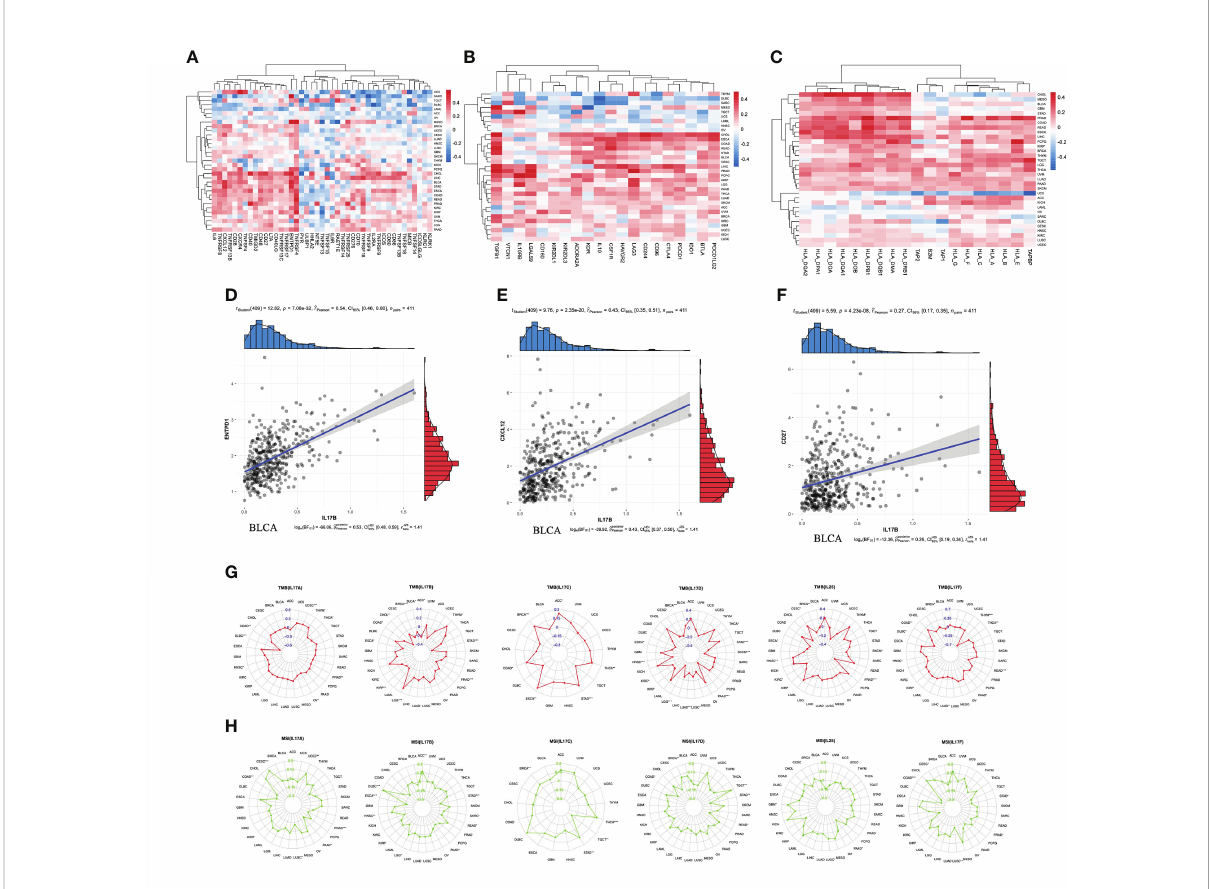
FIGURE 7 The correlation between IL-17B expression and immunomodulators including immunostimulators (A) , immunoinhibitors (B) , and MHC molecules (C) . The scatter plots represent the top four strongest correlations in each heatmap (D – F) . The correlation between IL-17A – F expression and immunotherapeutic biomarker (TMB and MSI). The red radar charts represent the association between TMB (G) and IL-17A, IL- 17B, IL-17C, IL-17D, IL-25, and IL-17F. The green radar charts represent MSI (H) and IL-17A, IL-17B, IL-17C, IL-17D, IL-25, and IL-17F. ( ∗∗∗ p < 0.001; ∗∗ p < 0.01; ∗ p <